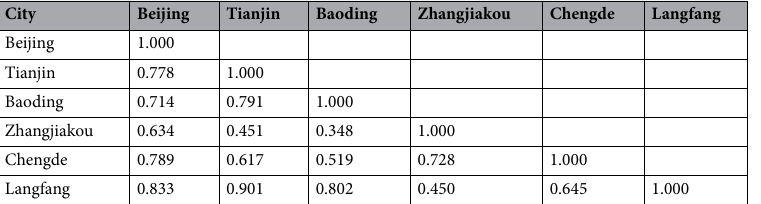
Table 4. Pearson correlation coefficients between